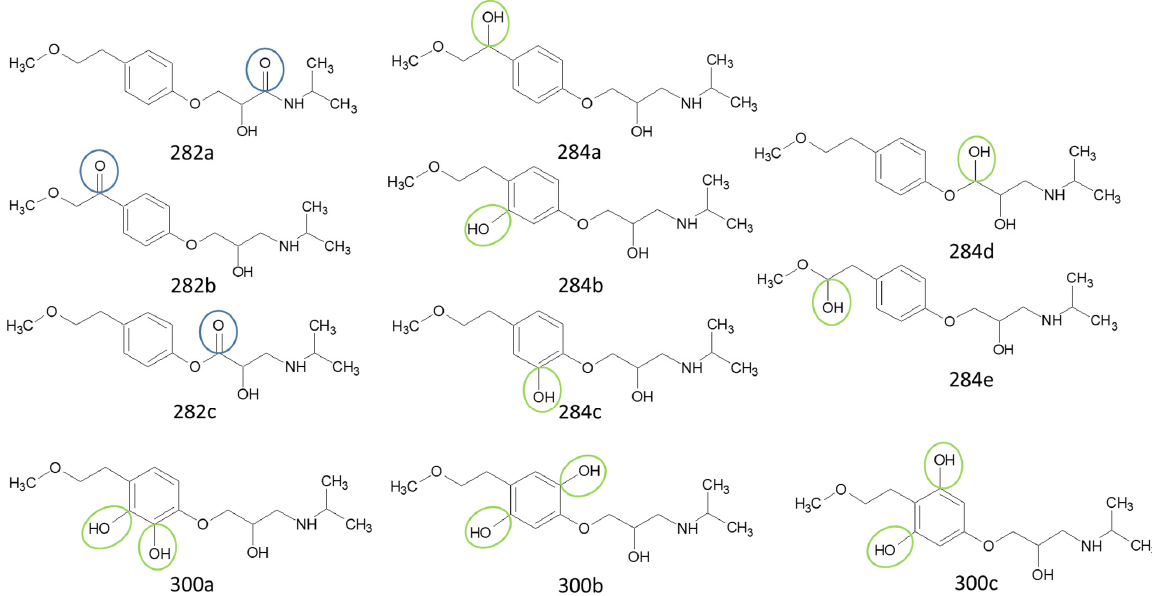
Figure 4. Structure proposals of degradation and transformation products from UV- irradiation and ozonation as used for QSAR analysis. Numbers correspond to rounded m/z values, index letters refer to isomers.